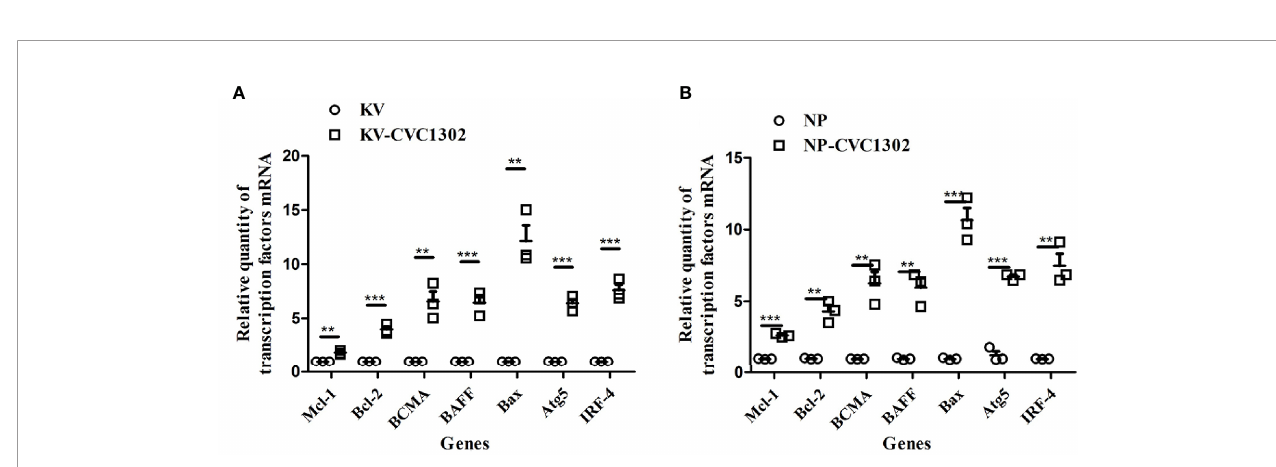
FIGURE 6 | The apoptotic nuclei of LLPCs from mice immunized with KV (left) or KV- CVC1302 (right). Samples were collected at 90 dpi. LLPCs are shown in green, and the nuclei (DAPI) are shown in blue. The red and yellow arrows indicate shrunken and normal LLPC nuclei, respectively.